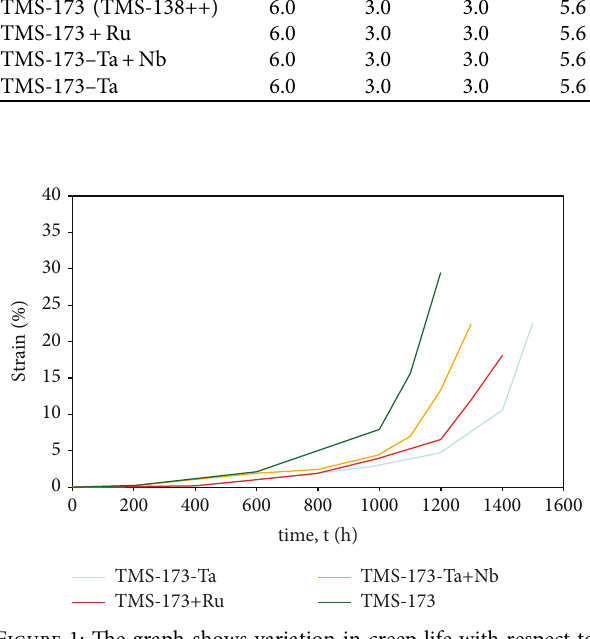
Figure 1: The graph shows variation in creep life with respect to strain % at 900 ° C temperature and 392MPa stress